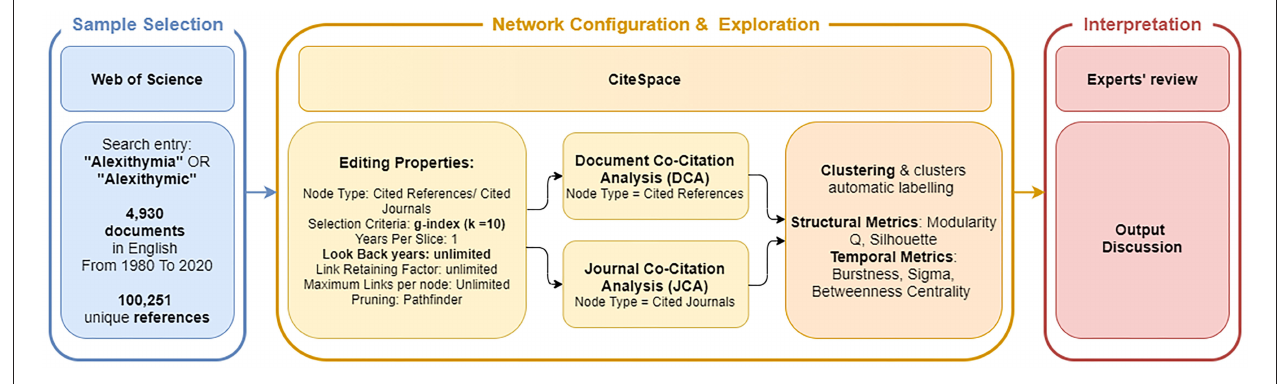
FIGURE 1 | Overview of the study